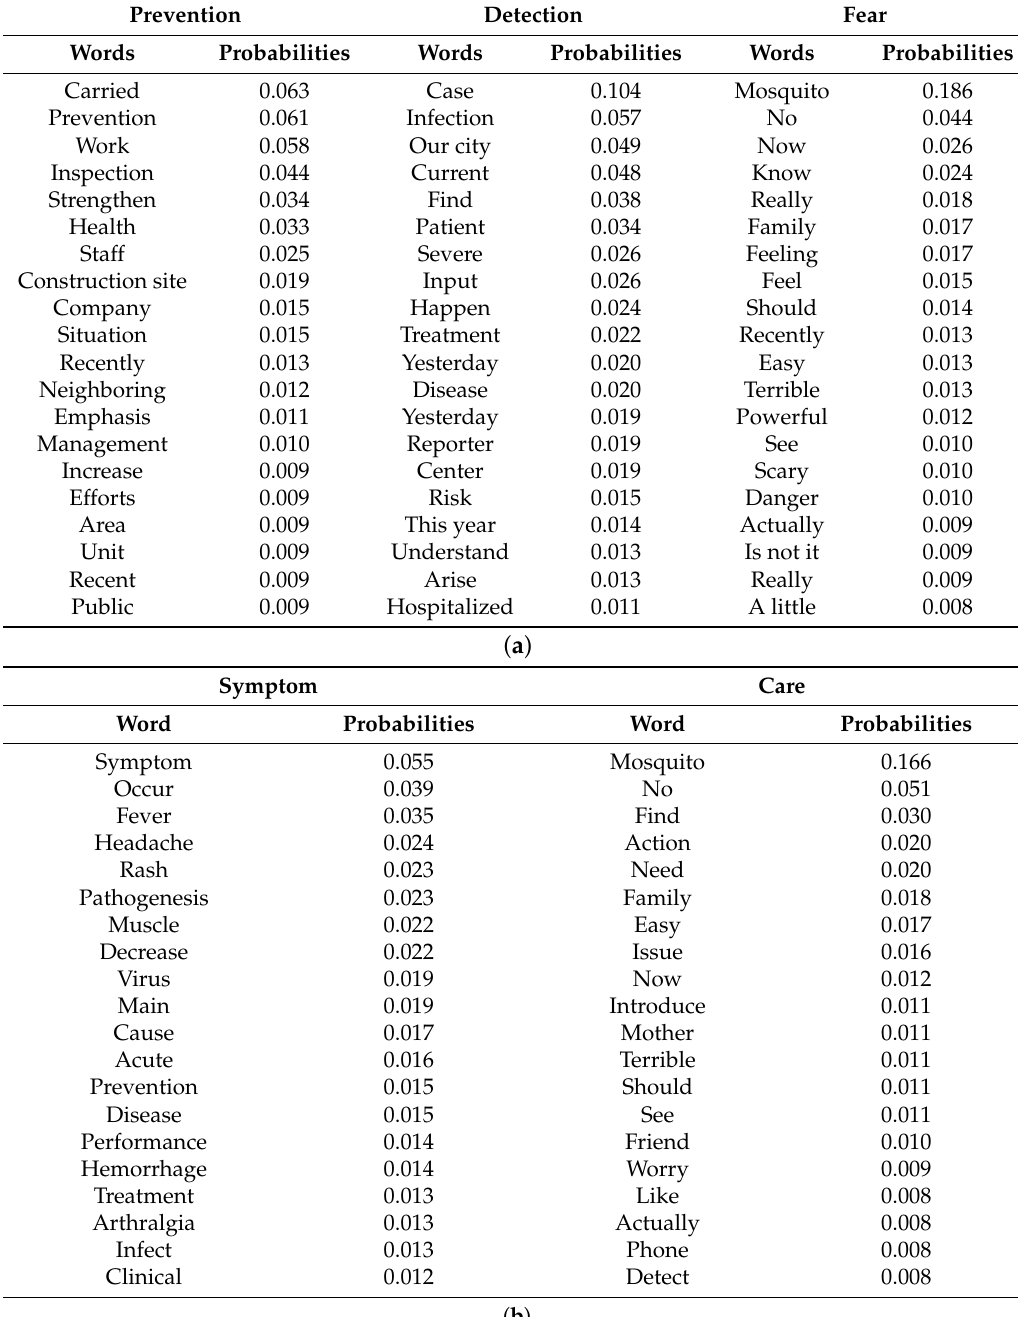
Table 2. The word frequency distribution of different topics: ( a ) prevention, detection, fear; ( b ) symptom,